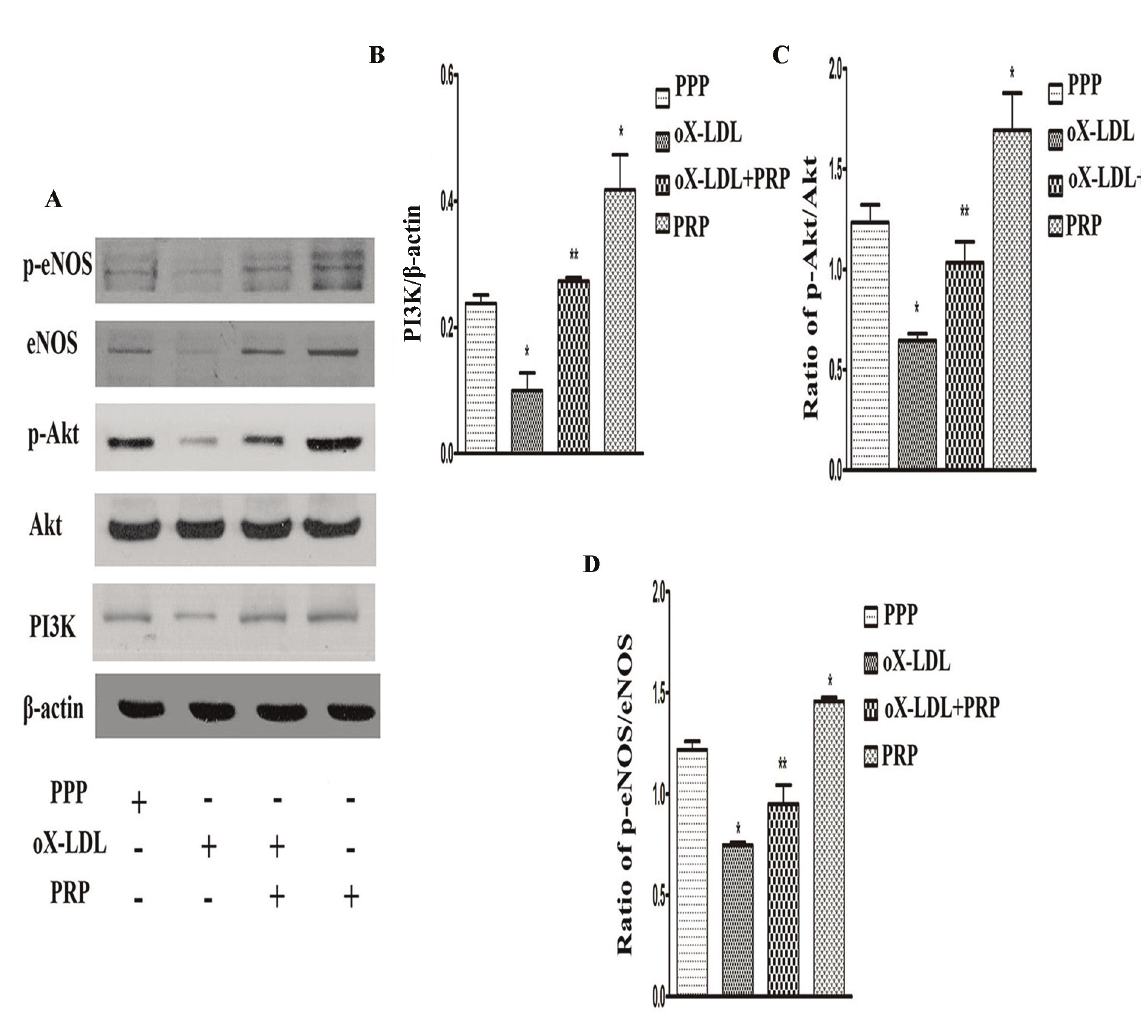
Figure 4: Effects of PRP on modulation of the PI3K/Akt/eNOS pathway (mean ± SD). A: PI3K, Akt, p-Akt, p-eNOS and eNOS were detected by western blotting. B: PI3K. C: p-Akt/Akt. D: p-eNOS/eNOS. *p<0.05 versus control; **p<0.05 versus